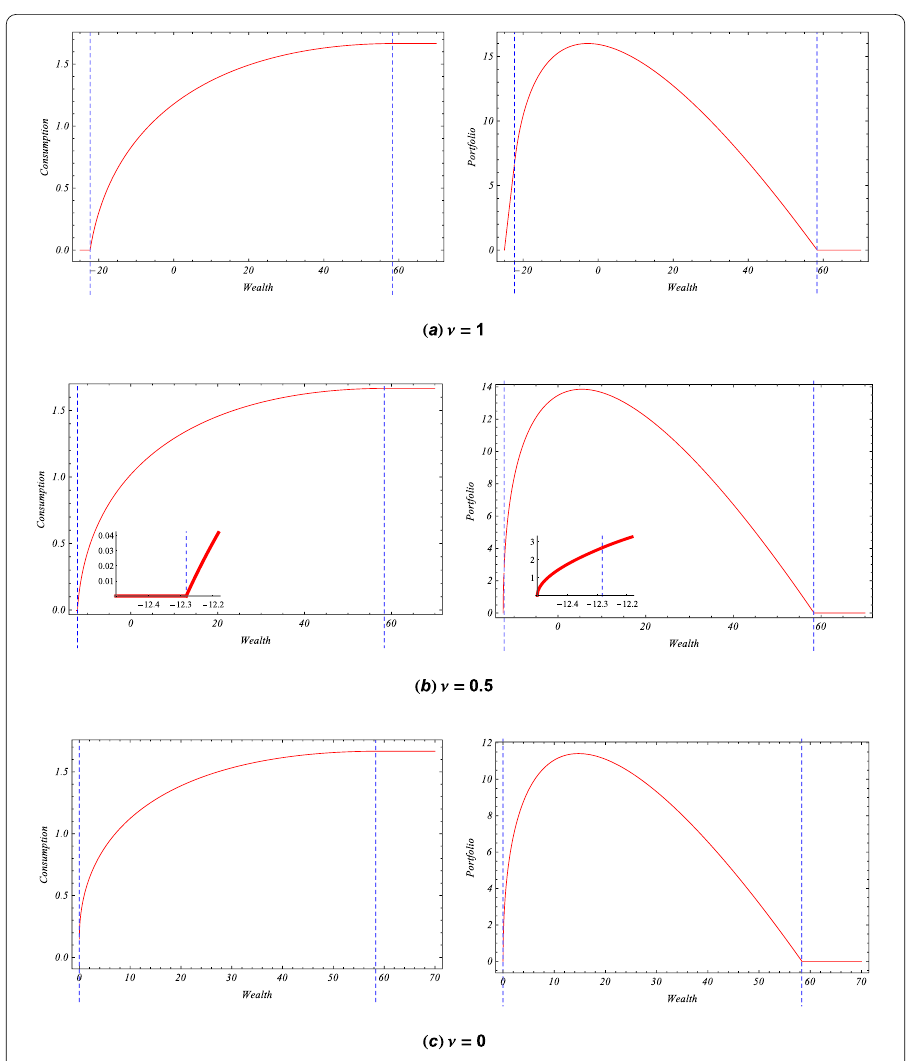
Figure 1 The optimal consumption and portfolio as a function of wealth ( ρ = 0.04, r = 0.02, μ = 0.05, σ = 0.2, I = 0.5, R =